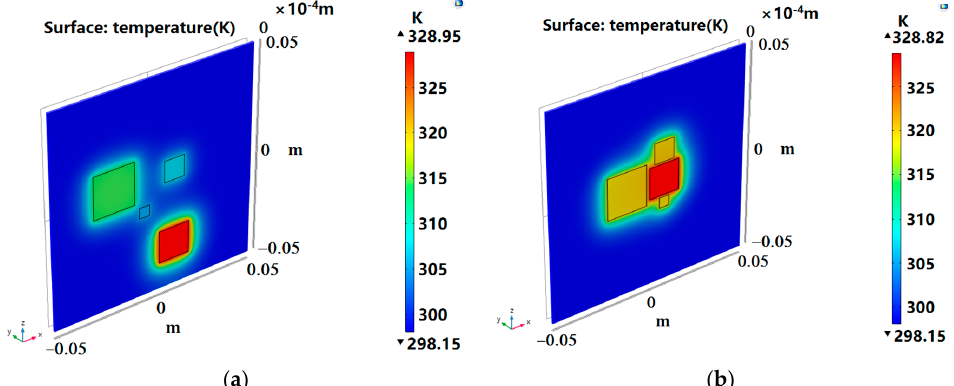
Figure 7. Situation 3: initial layout ( a ) and optimized layout ( b ).